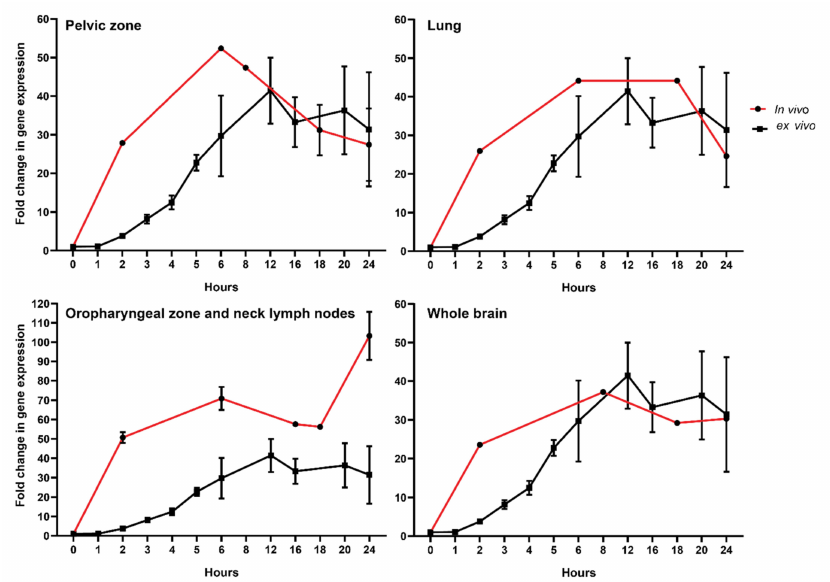
Figure 3. Comparison of FDXR responses to ionizing radiation in healthy donors’ PBMCs exposed ex vivo with RT patients’ whole blood exposed in vivo. Isolated PBMCs were exposed to 2 Gy (0.5 Gy/min) while in vivo sample values were corrected to 2 Gy using dose to the blood calculations (Table 2) as described in the material and methods